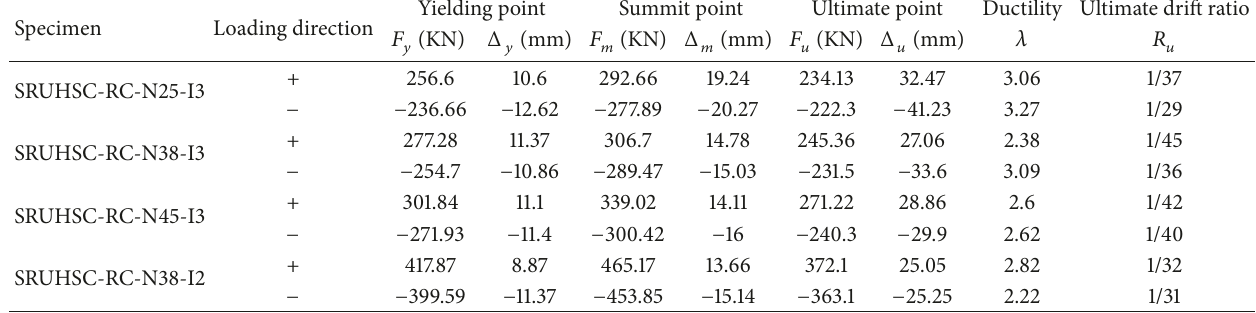
Table 5: The skeleton curve characteristic value.